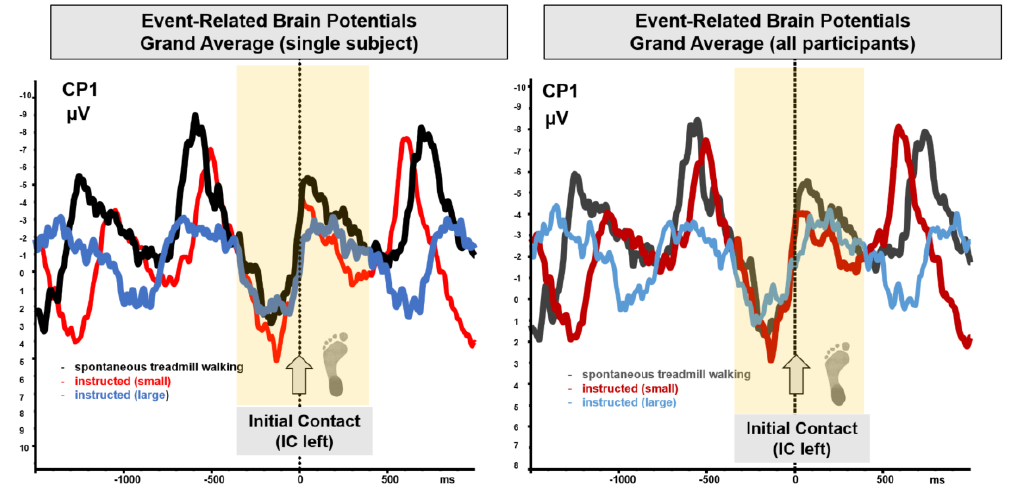
Figure 5. Grand mean event-related potential (ERP )waveforms averaged across the three participants time-locked to the left initial contact of the gait cycle (right column) at the left hemisphere EEG electrode position CP1 for the different walking conditions of spontaneous (gray) and instructed (small steps (red), large steps (blue)) treadmill walking. Grand average ERP waveforms of a single subject, time-locked to the left initial contact of the gait cycle (left column) at the left hemisphere EEG electrode position CP1 for the different walking conditions of spontaneous (black) and instructed (small steps (red), large steps (blue)) treadmill walking. Yellow shaded parts, please see explanation in the text.